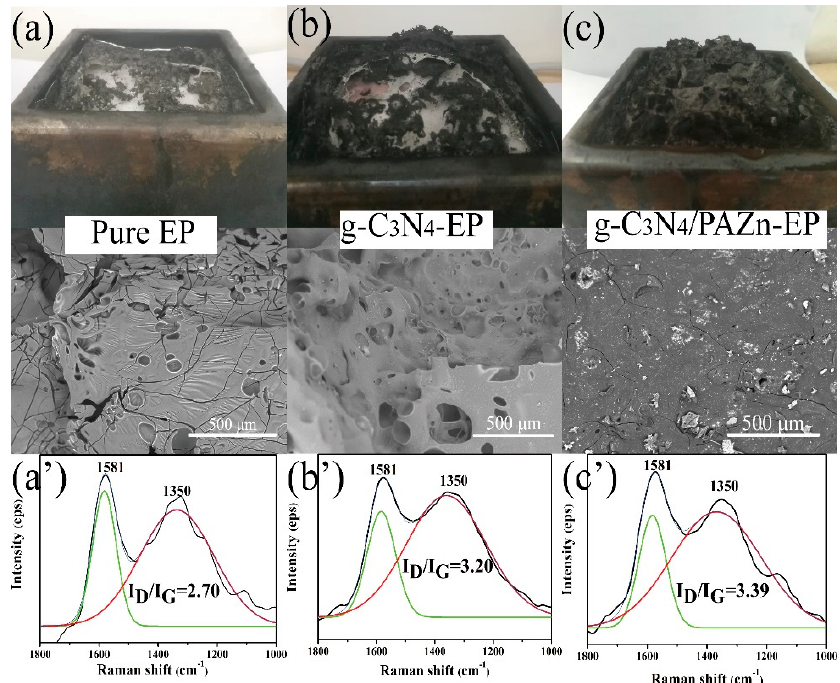
Figure 7. Digital photograph and SEM analysis of char residues ( a – c ) and Raman spectrometer analysis of char residues ( a’ – c’ ).